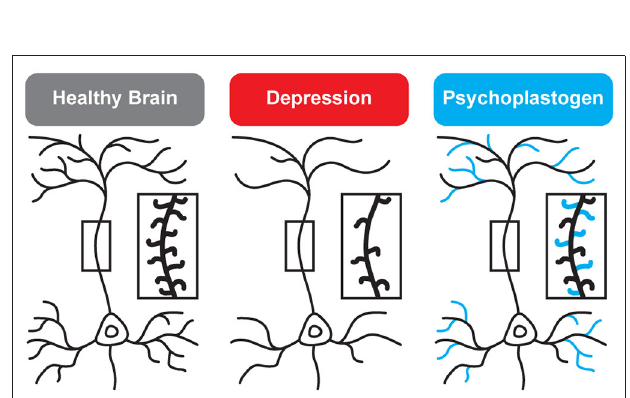
FIGURE 2 | Genetic and environmental factors lead to the cortical atrophy observed in depression, which includes retraction of dendritic branches and loss of dendritic spines. These structural changes are reversed by psychoplastogens